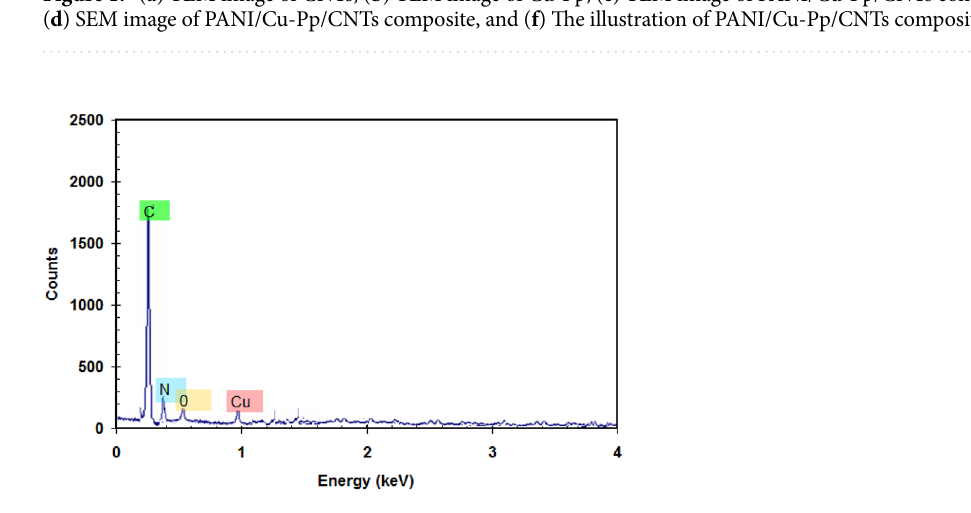
Figure 2. EDX analysis of PANI/Cu-Pp/CNTs